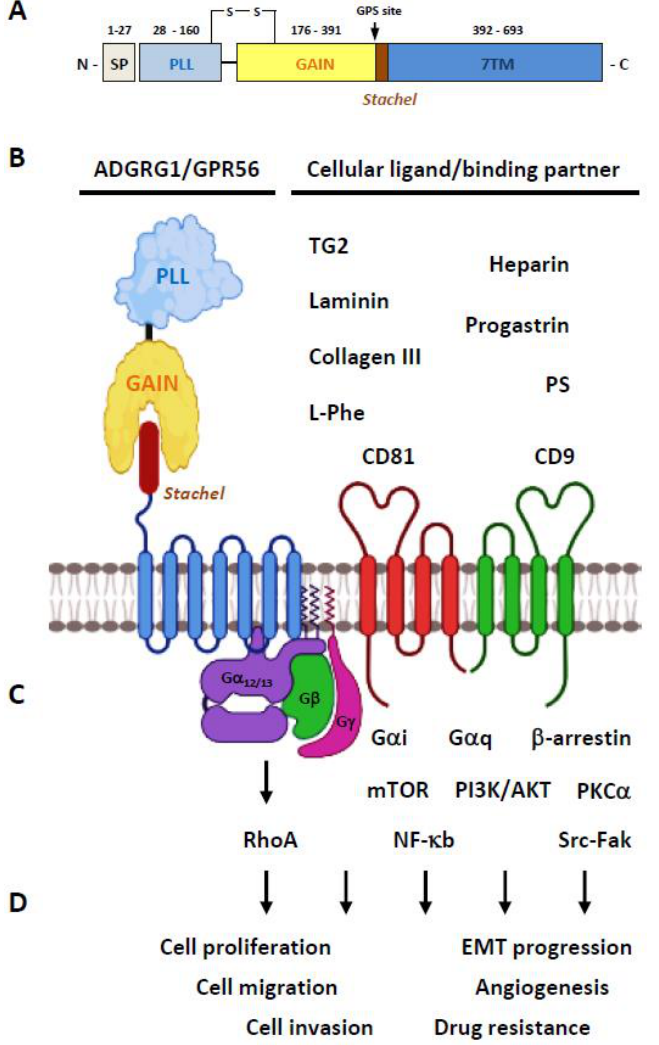
Figure 2. Overview of the ADGRG1/GPR56 protein. ( A ) Schematic depicting the domain organi- zation of the GPR56 receptor protein. The light-purple and light-yellow rectangles represent the PLL and GAIN domains, respectively. The 7TM region is represented by a light blue rectangle. The Stachel tethered peptide is indicated by a brown rectangle. SP, signal peptide; GPS, GPCR proteolysis site. ( B ) Diagrams showing the GPR56 receptor and its known cellular ligands and binding partners. ( C ) The GPR56-mediated signaling pathways reported to date. ( D ) The tumorigenic functions known to be mediated by GPR56. Illustration was generated using the Biorender